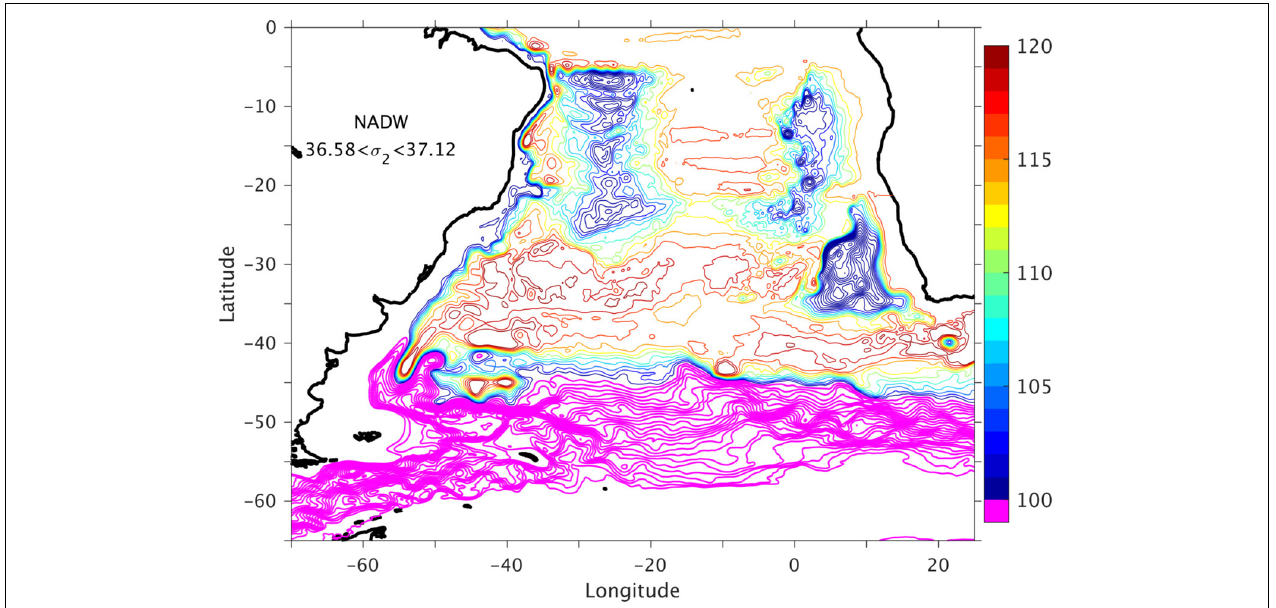
FIGURE 13 | Modeled long-term mean horizontal transport streamfunction for the layer of NADW (36.58 < σ 2 < 37.12 kg m − 3 ). Pink streamlines (4 Sv increment) indicate the eastward transport of the ACC, blue to yellow streamlines (2 Sv increment) represent the southward spreading of the NADW from